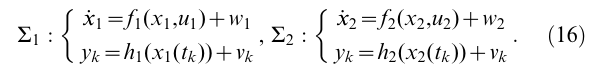
PLoS Computational Biology |